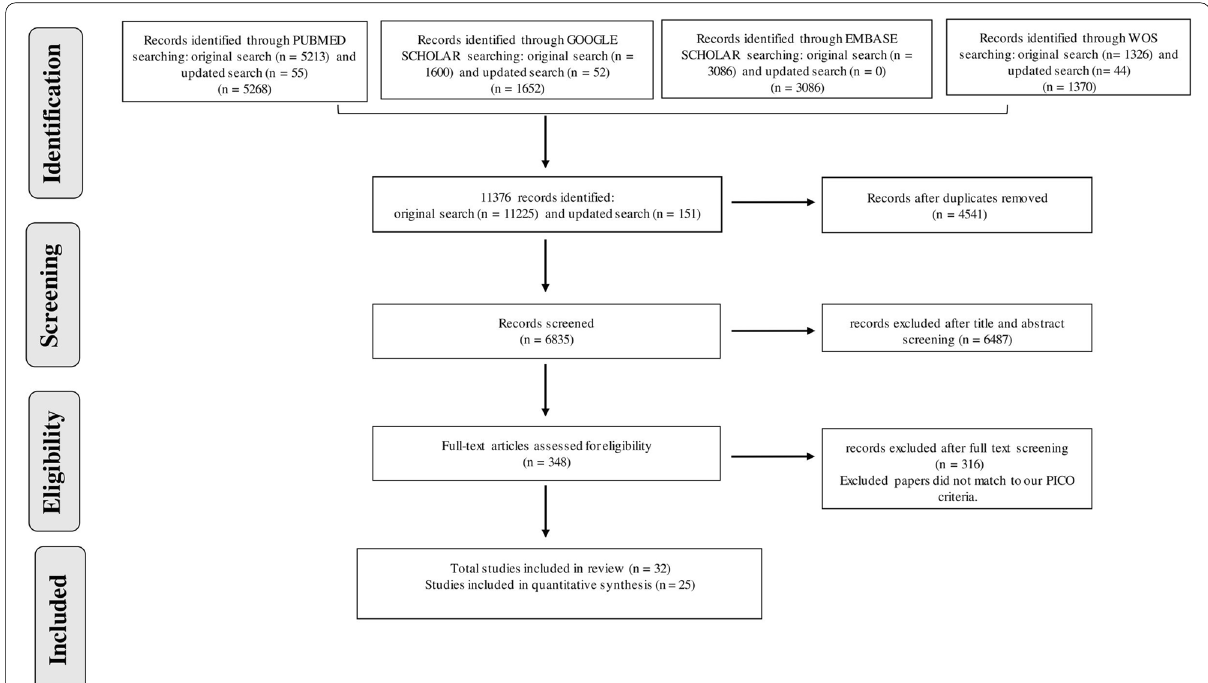
Fig. 1 PRISMA flow diagram illustrating the search process which eligible articles were identified for data